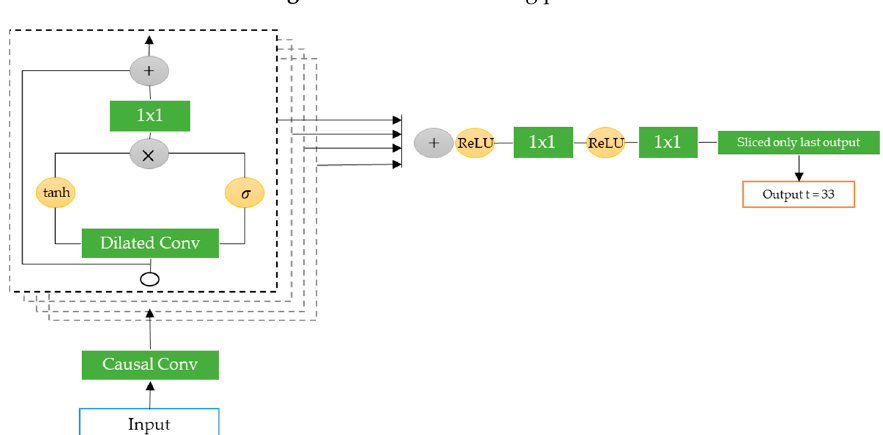
Figure 6. Overview of residual dilated convolutional block and gated activation function.